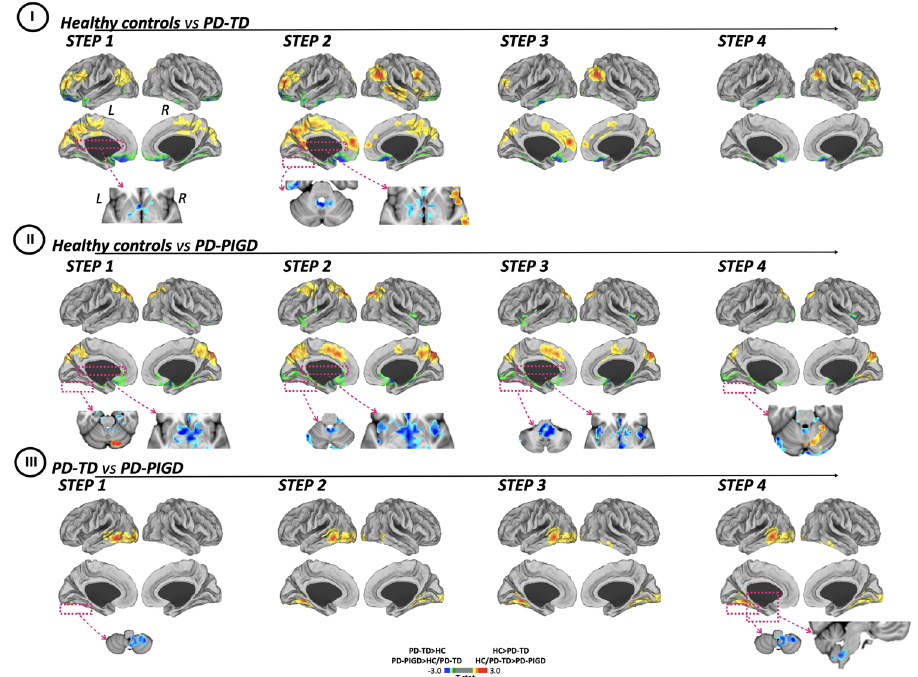
Fig. 2 Differences between Parkinson ’ s disease participants and healthy controls in stepwise functional connectivity of the cerebellar seed region. Cortical maps represent the signi fi cant differences in stepwise functional connectivity values between PD subtypes and healthy controls ( I , II ) and among PD groups ( III ). Statistical analysis was adjusted for age and gender. Results were corrected for multiple comparisons using a threshold-free cluster enhancement method combined with nonparametric permutation testing at p -value <0.05 FWE-corrected. Color bars show the t-statistic applicable to the image. HC, healthy controls; L, left; R, right; PD-TD, Parkinson ’ s disease tremor dominant; PD-PIGD, Parkinson ’ s disease with postural instability and gait